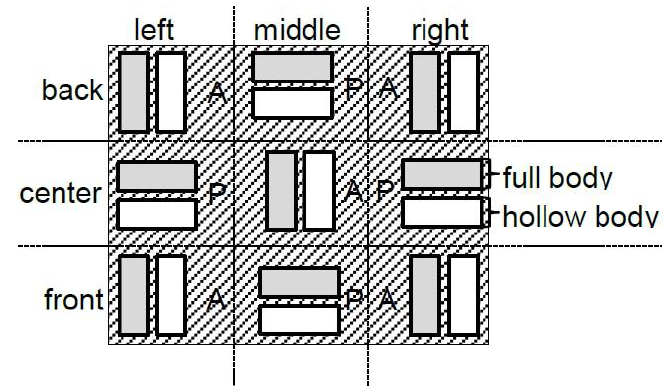
Figure 2. Model positioning (A: across the front; P: parallel to the front).